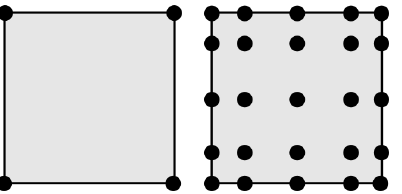
Figure 1. An example of 2D first-order finite element ( left ) and a fourth-order spectral element ( right